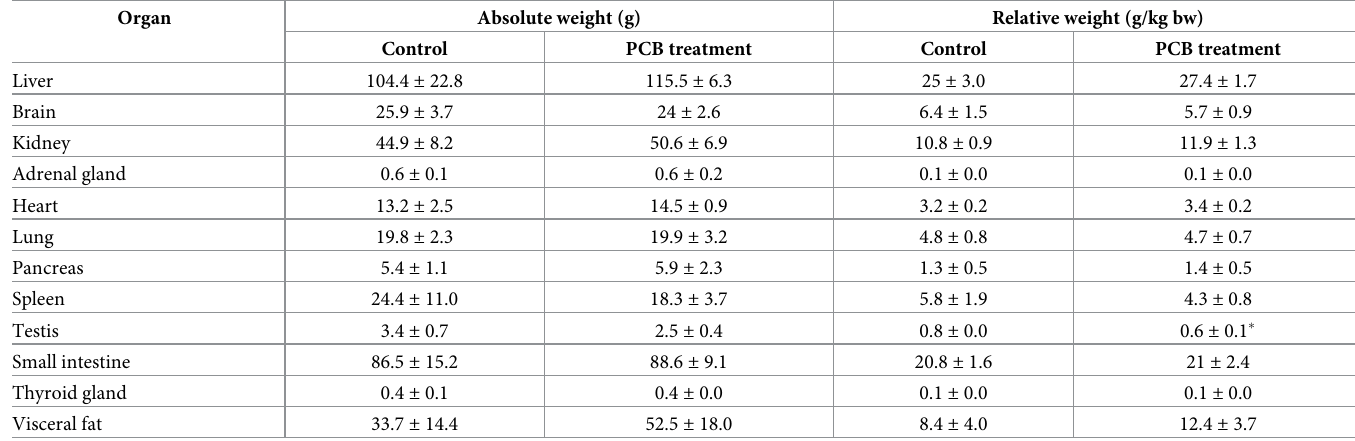
Table 1. Absolute and relative organ weights (mean ± SD) of the control cats and PCB-treated cats ( � : Significant differences between two groups, P < 0.05). Organ